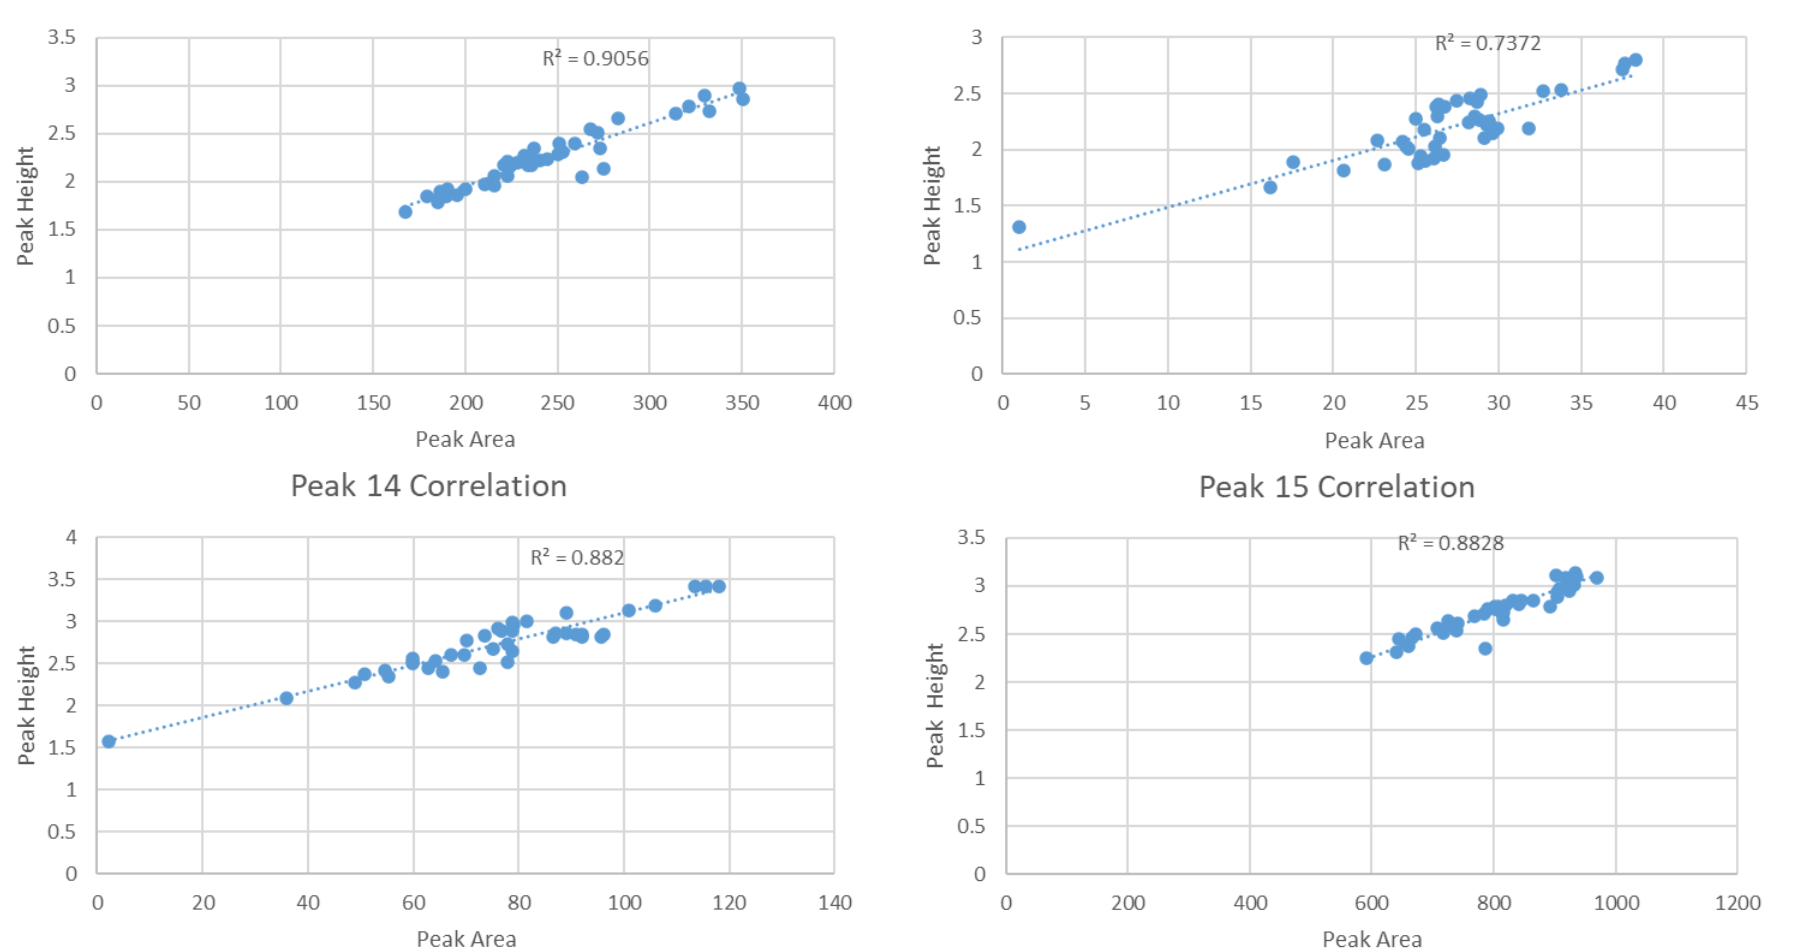
Figure A1. Correlations between the peak areas fit in OriginPro 2019b and the peak heights found in the corresponding FTIR spectra in the region between 4000 and 2000 cm -1 of the spectra shown in Figure 2. Despite the appearance of lack of fit in Figure 2, there are strong correlations. Both axes are unitless because all spectra were standardised for